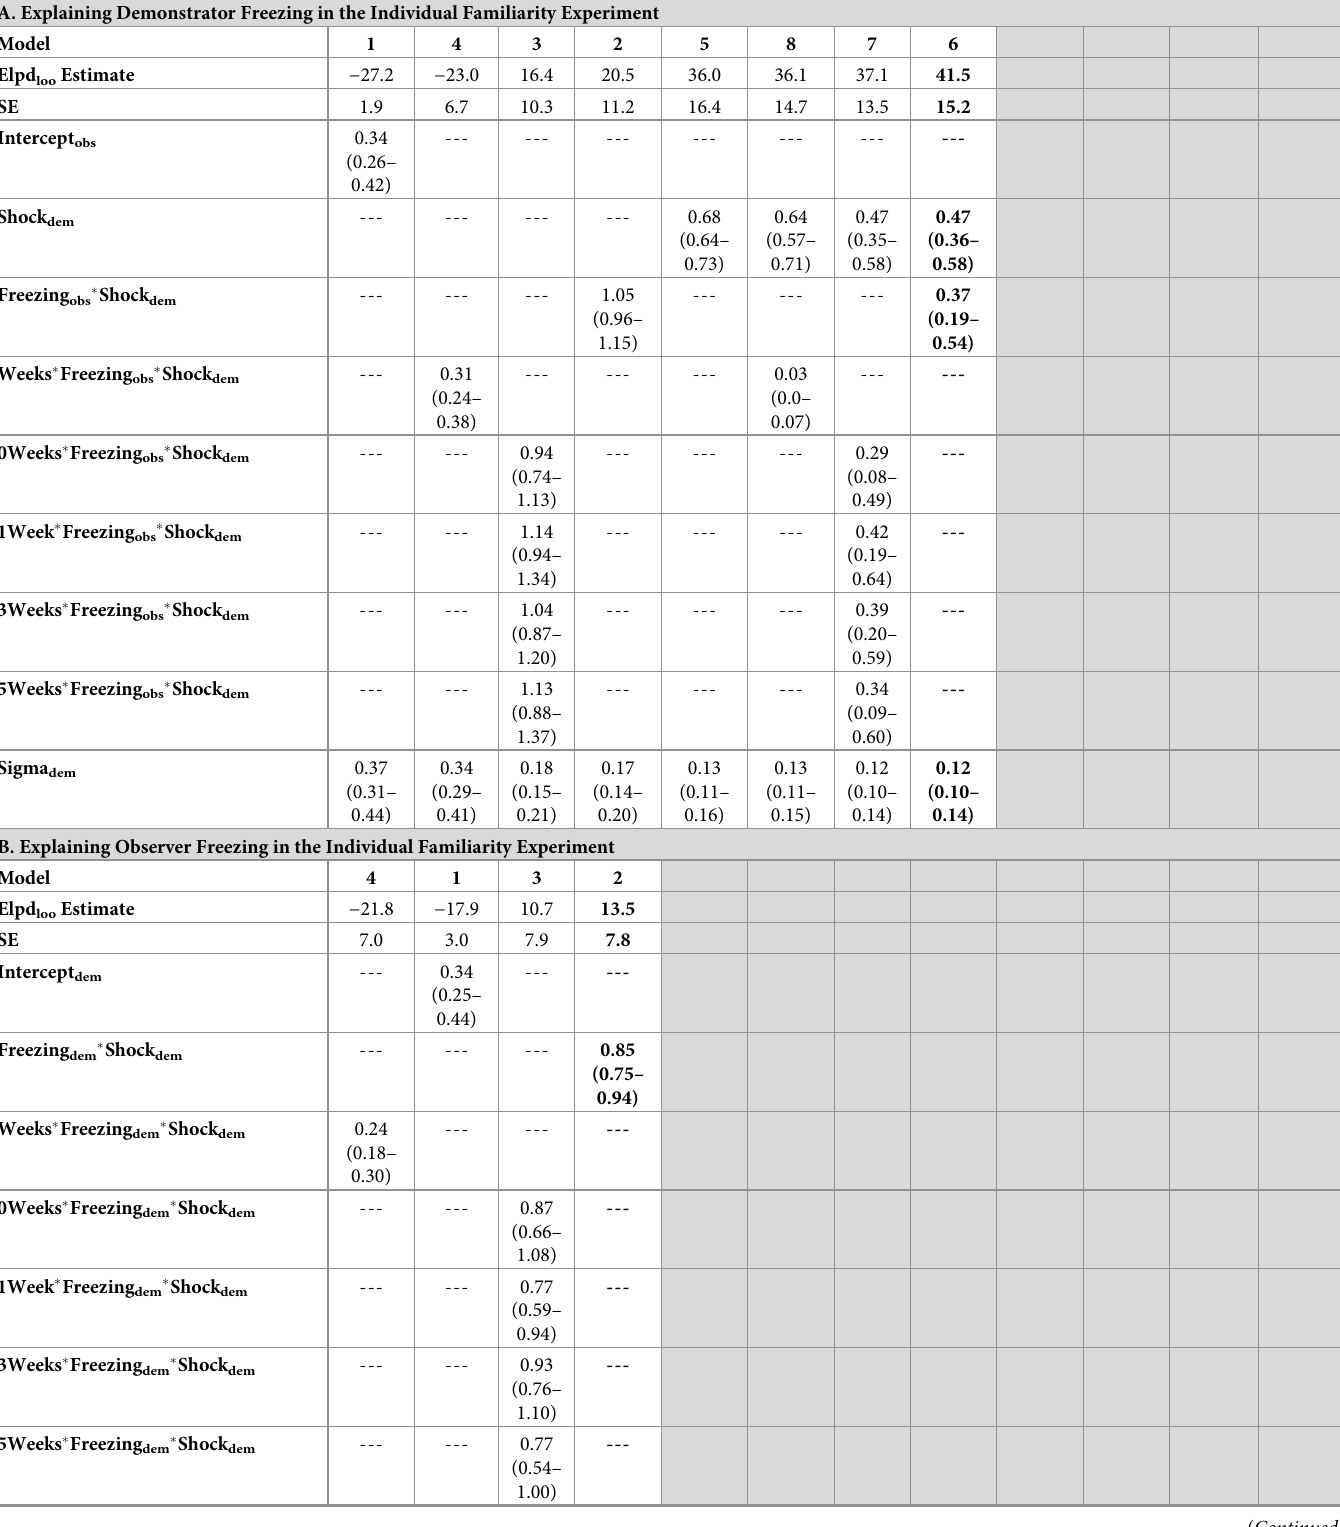
Table 1. Model comparisons for the individual and strain familiarity